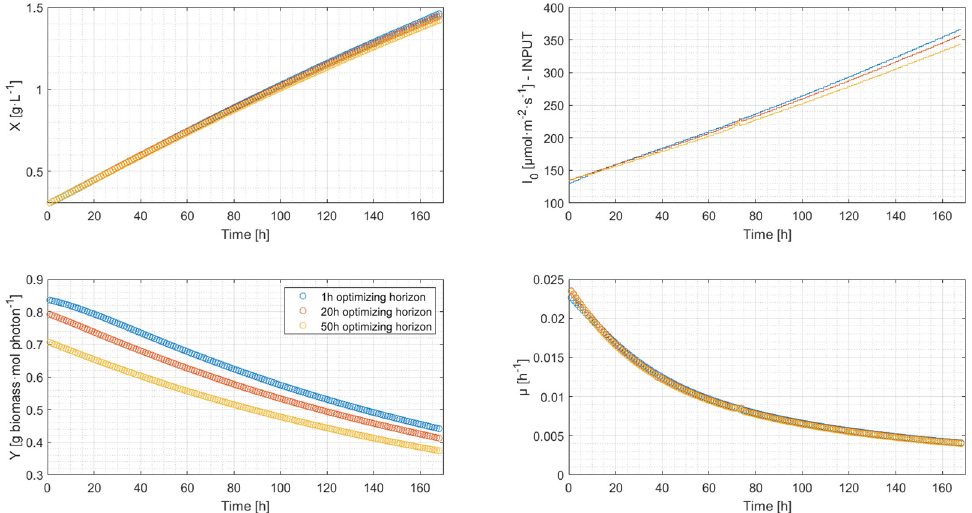
Figure 7. Simulation results on a seven-day batch with different optimization horizons (1-h horizon—blue, 20-h horizon—red and 50-h horizon—yellow).